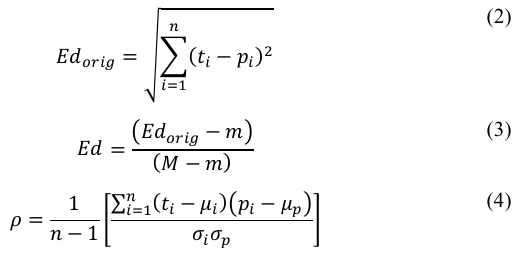
Figure 1. False colour composite bands 543: RGB of the scenes LC81270452013352LGN00 (left) and LC81270452015182LGN00 (right). Hanoi city is located in right-bottom corner. The LC81270452013352LGN00 is almost cloud free while the LC81270452015182LGN00 is affected by thin cloud